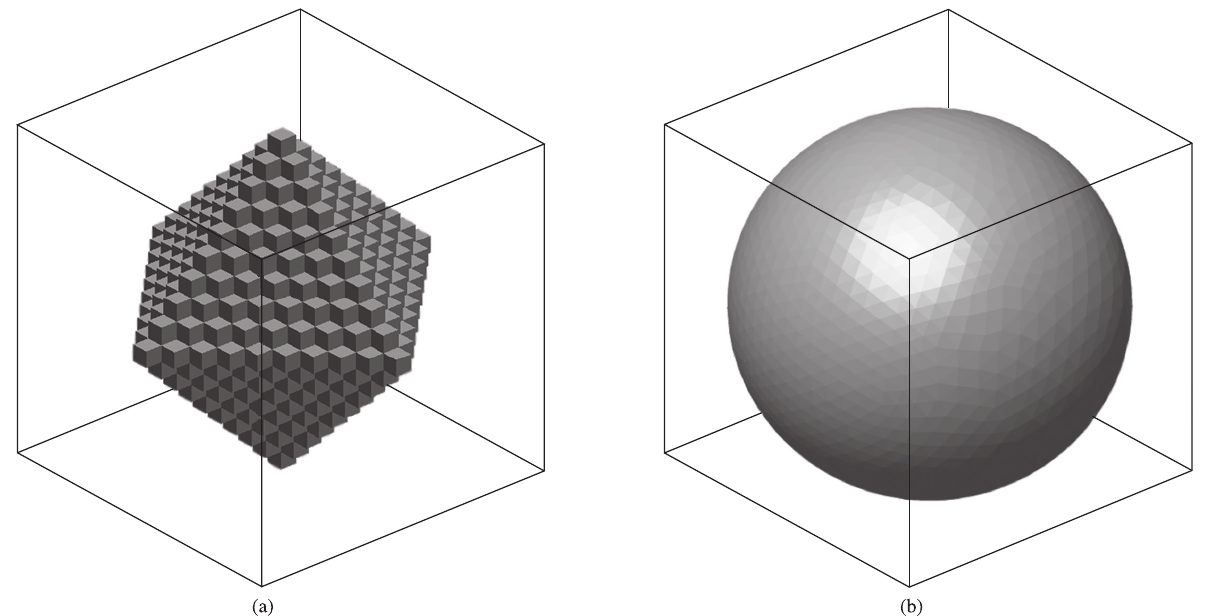
Figure 2. Comparison between the shape of a growing region in cellular automata, (a), and spherical growth, (b).